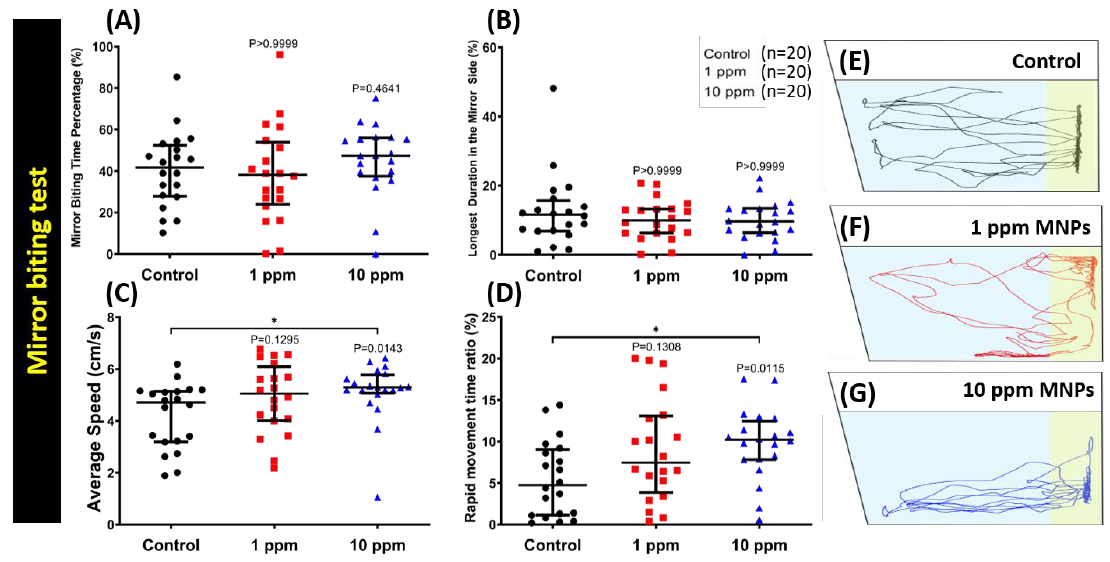
Figure 3. Mirror biting behavior endpoint comparisons between the control group, 1 ppm, and 10 ppm Fe 3 O 4 MNPs-exposed zebrafish groups after two weeks of exposure. ( A ) Mirror biting time percentage, ( B ) longest duration in the mirror side, ( C ) average speed, and ( D ) the rapid time movement ratio were analyzed. The locomotion trajectories of control, 1, and 10 ppm MNPs-exposed fish in the mirror biting test were presented in ( E – G ), respectively. The data are expressed as the median with interquartile range and were analyzed by the Kruskal-Wallis test continued with Dunn’s multiple comparisons test as a follow-up test ( n = 20, * p < 0.05).